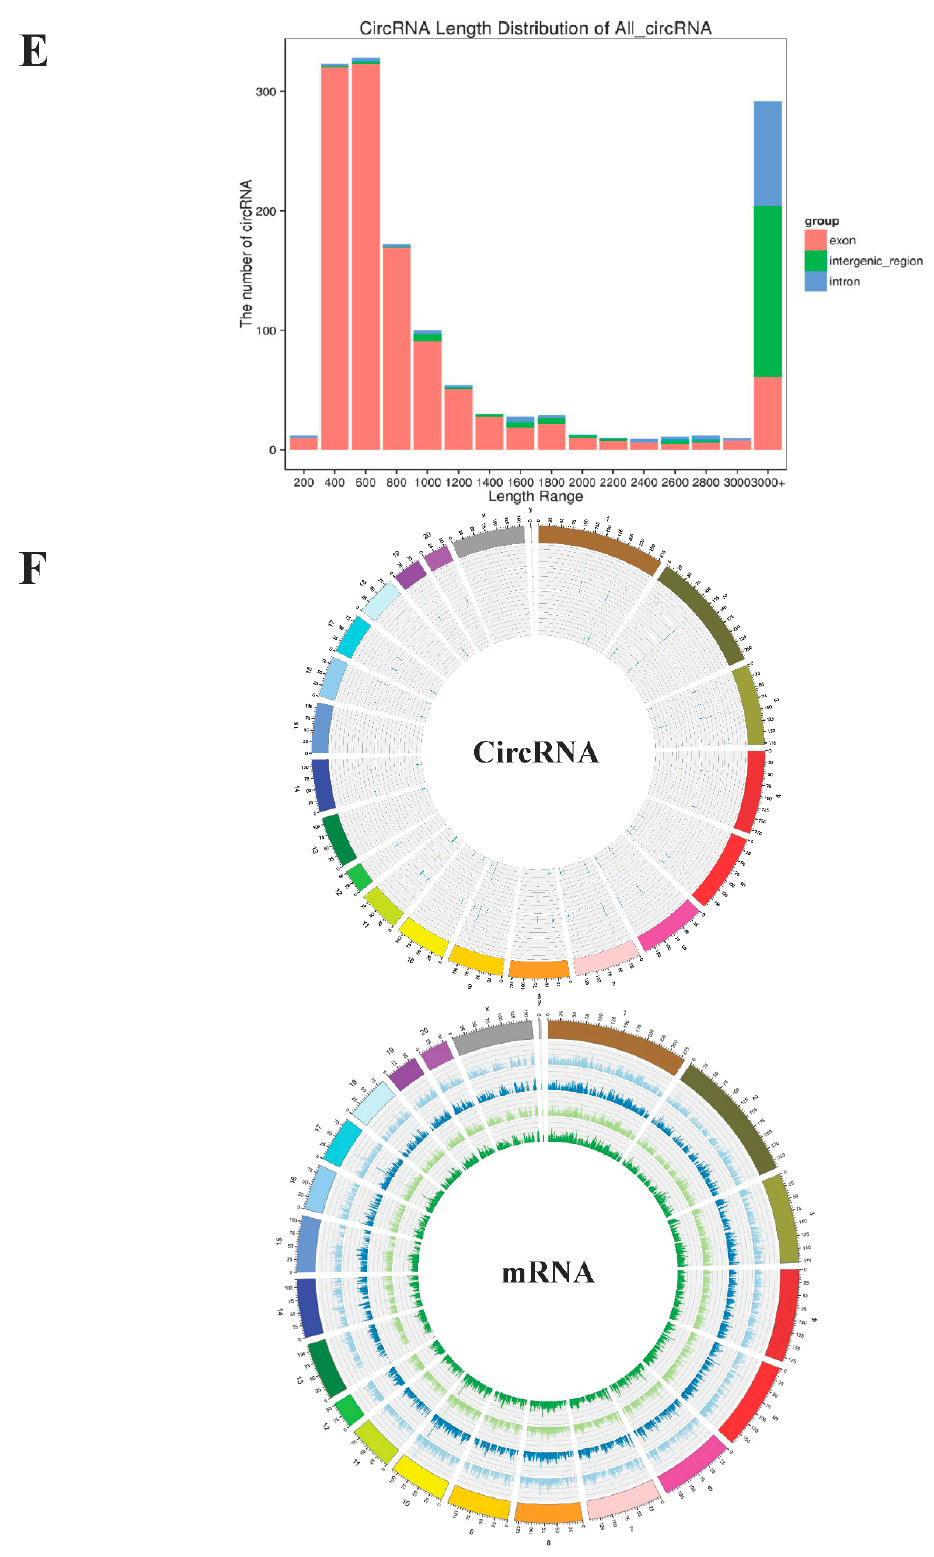
Figure 2. Deep sequencing of circRNAs in GnRH-treated rats. ( A ) Experimental flow chart. ( B ) Pie chart of mRNA and circRNA. ( C ) Statistical analysis of circRNA sources. ( D ) Statistical analysis of circRNA expression in the different groups. ( E ) Statistical analysis of circRNA length. ( F ) Circos plot containing circRNA and mRNA data.